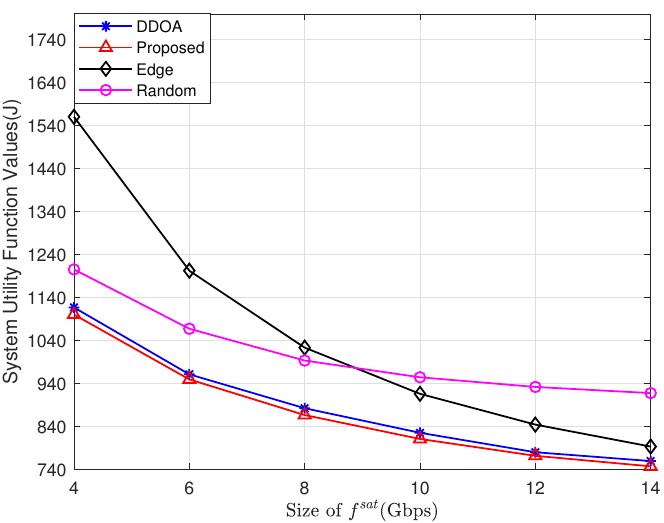
Figure 6. The system utility function values under different processing rates f sat of the MEC server on the LEO satellite for different offloading algorithms.